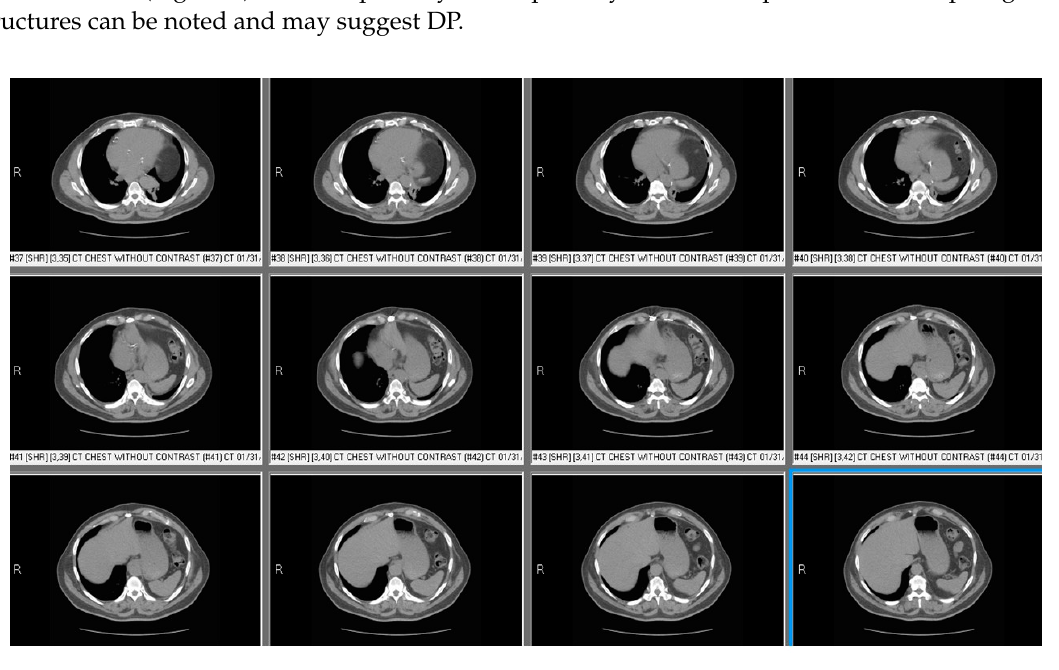
Figure 4. Computed Tomography (CT) chest of patient with left diaphragmatic palsy showing abdominal contents beside heart and at higher level compared to liver suggesting left diaphragmatic palsy.